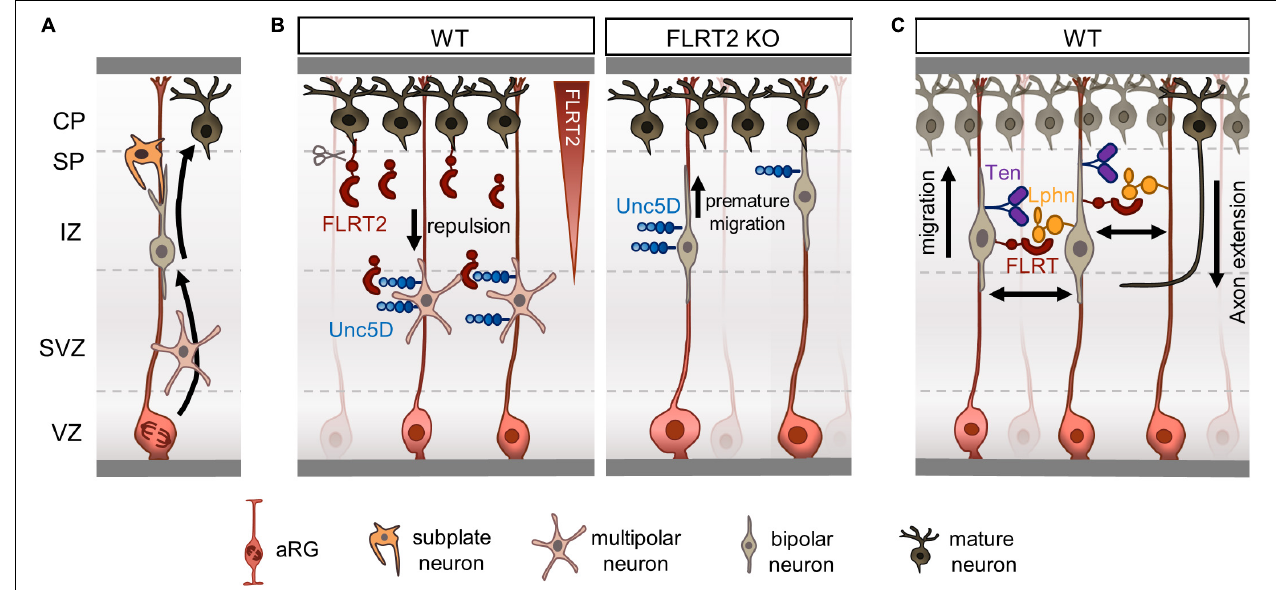
FIGURE 2 | Fibronectin leucine-rich repeat transmembrane proteins (FLRTs) regulate radial migration by repulsion. (A) Overview of radial migration. Newborn neurons transition from multipolar to bipolar morphology during their migration to the CP. Subplate neurons facilitate the displacement of bipolar neurons to the CP by direct contacts. (B) FLRT2-Unc5D contacts regulate radial migration of neurons by a repulsive mechanism. FLRT2 knockout causes premature migration of Unc5D+ neurons toward the CP. (C) Schematic depicting a model where FLRT and Teneurin bind to Latrophilin in trans on opposing RG fibers or